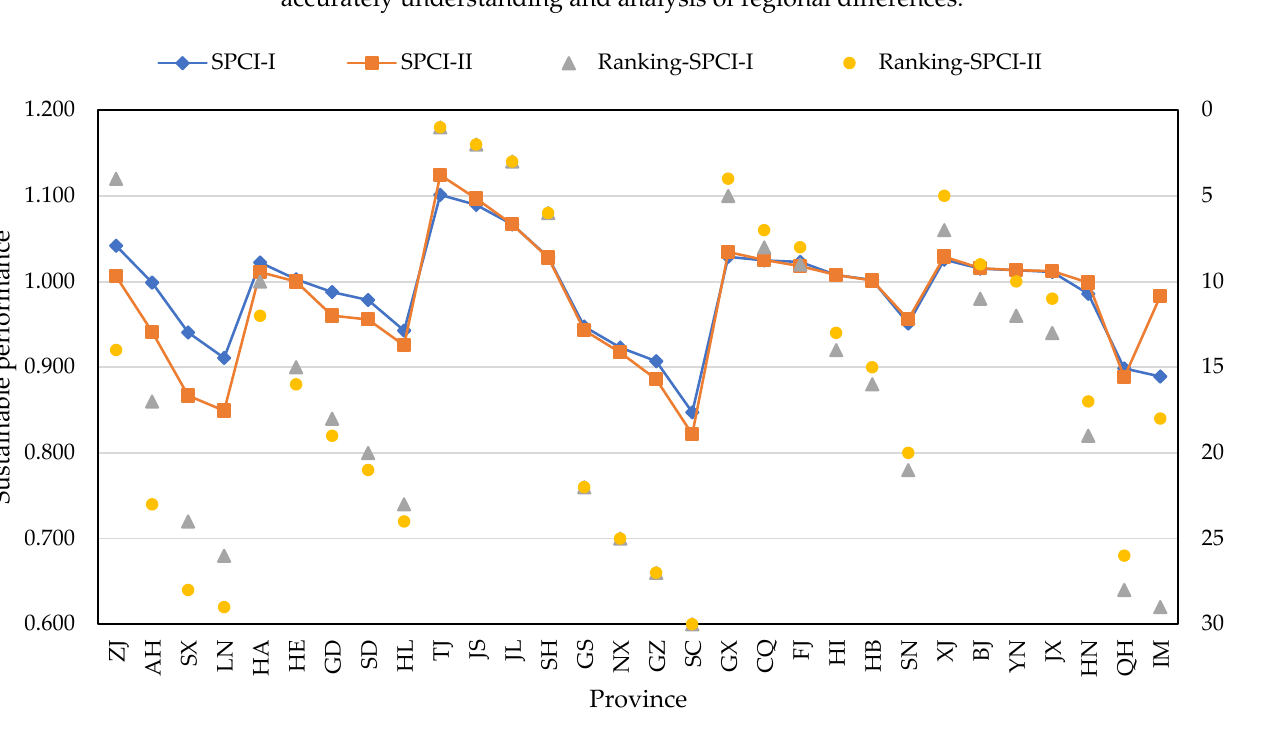
Figure 7. Comparison of the 2017 values of the SPCI in the 30 provinces.